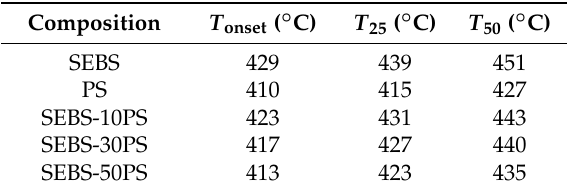
Table 3. Degradation temperatures of SEBS and the